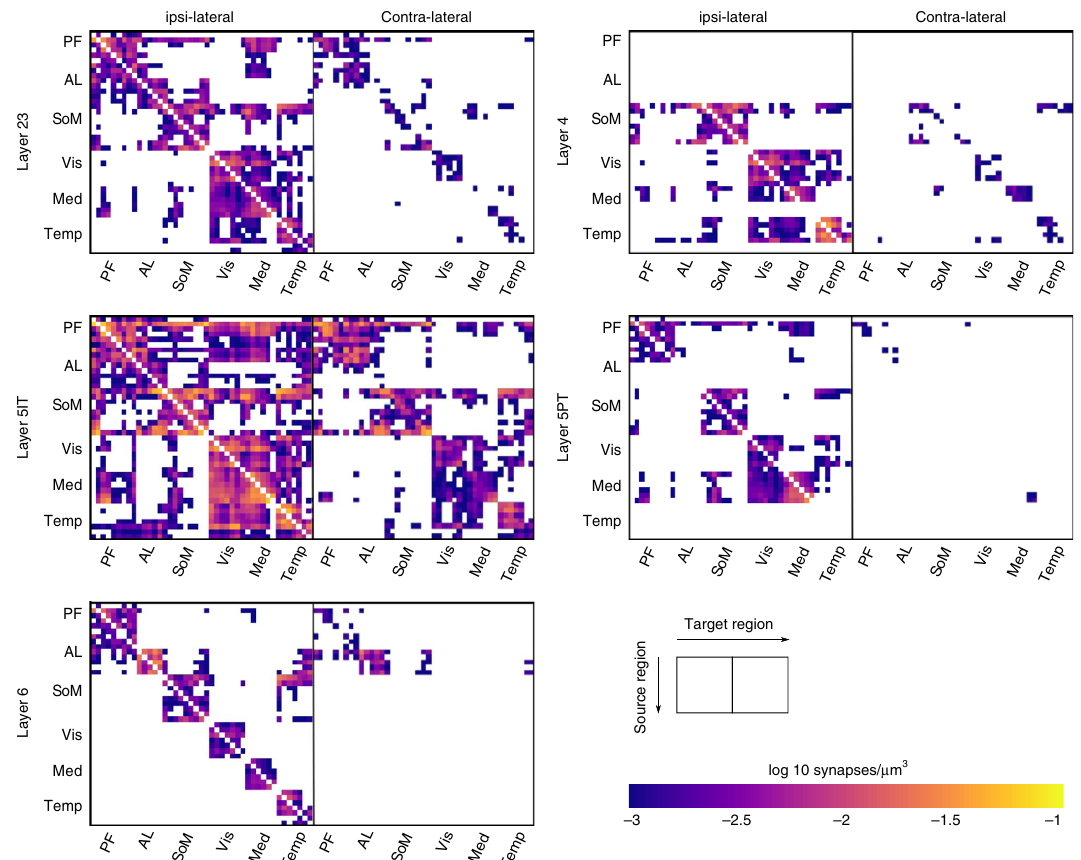
Fig. 1 Predicted synapse densities in target regions. Modules are labeled: PF: prefrontal, AL: anterolateral, SoM: somatomotor, Vis: visual, Med: medial, Temp: temporal. Exact order of brain regions and assignment to modules by Harris et al. 3 are also listed in Supplementary Table 1. White regions indicate no projections placed for that combination of source and target